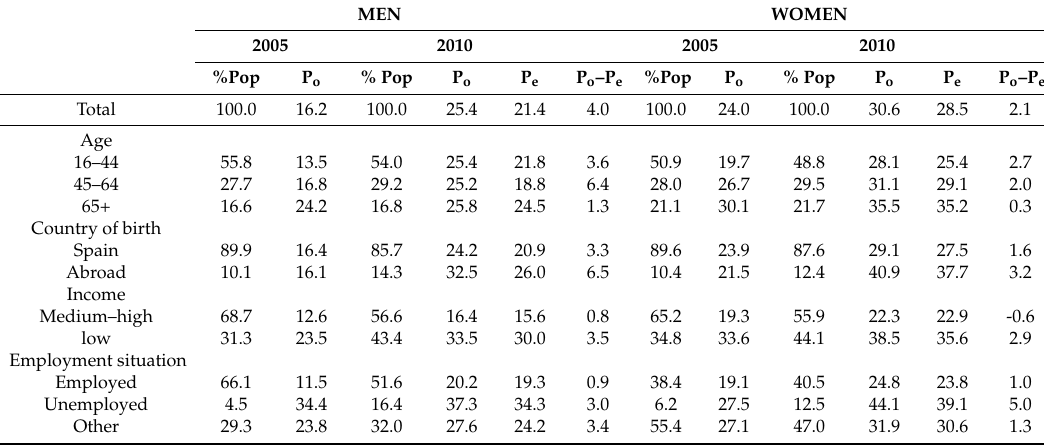
Table 5. Population distribution (% Pop), observed prevalence (P o ) of poor mental health risk in 2005 and 2010, expected prevalence (P e ) in 2010, standardizing according to the 2005 population structure of the variables included and difference between observed and expected